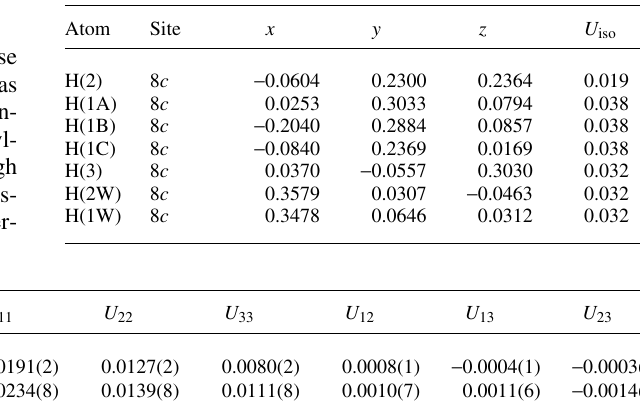
Table 2. Atomic coordinates and displacement parameters (in Å 2 ) .